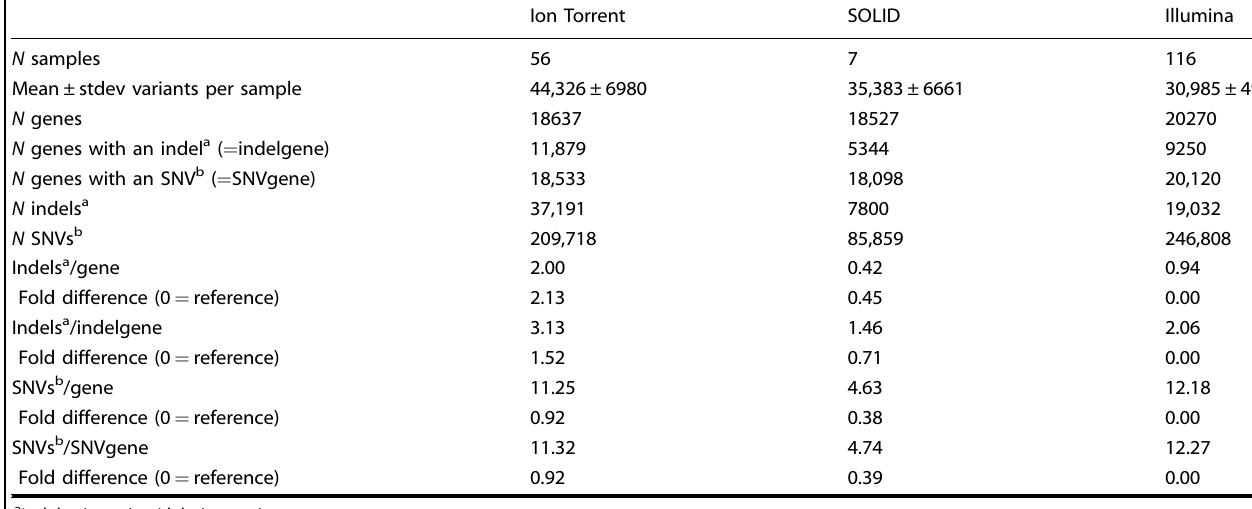
Table 1. Summary statistics for variants called using different sequencing